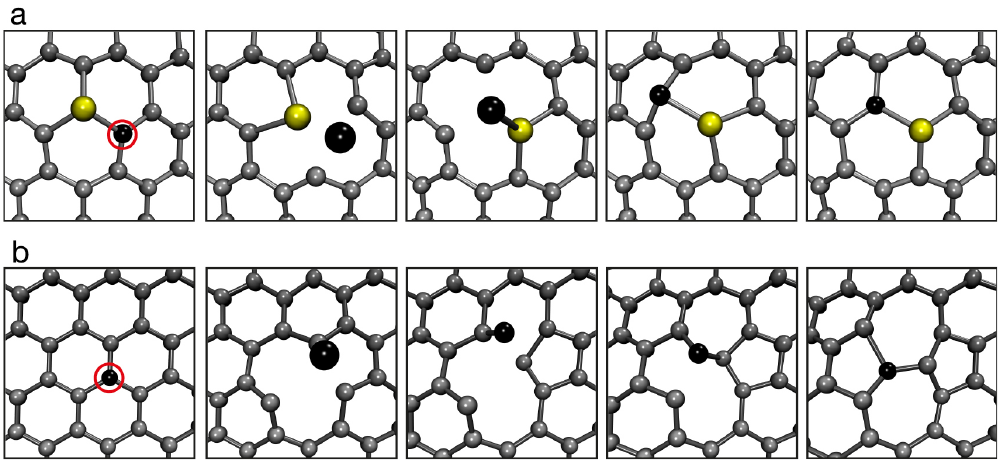
Figure 4. Ab initio molecular dynamics simulations of atom-number-conserving transformations in graphene. ( a ) Migration step of a Si impurity atom caused by an electron impact on its neighboring carbon atom (marked with a red circle). ( b ) Stone-Wales transformation caused by an electron impact on one of the carbon atoms (marked with a red circle). From Ref. [64].